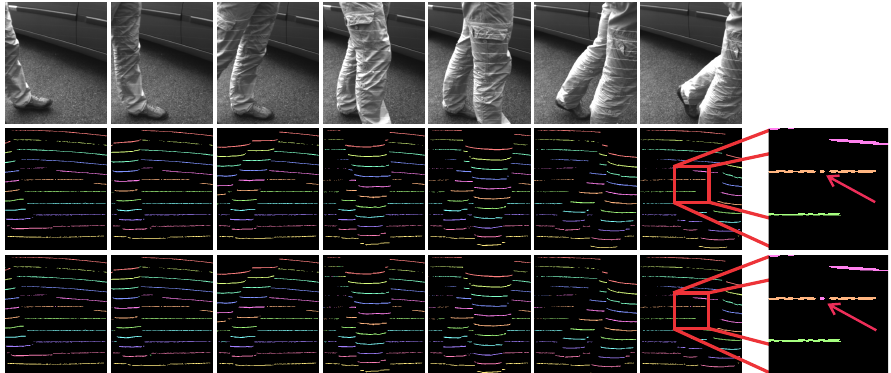
Figure 16. Visual examples of the results of the proposed light plane labeling procedure. The first row shows sample images from the outdoor dataset; the second row shows the (color-coded) manually-annotated ground truth; and the third row shows color-coded results of the labeling procedure. The images on the right side show an example of a labeling error, which is highlighted by arrows (best viewed in